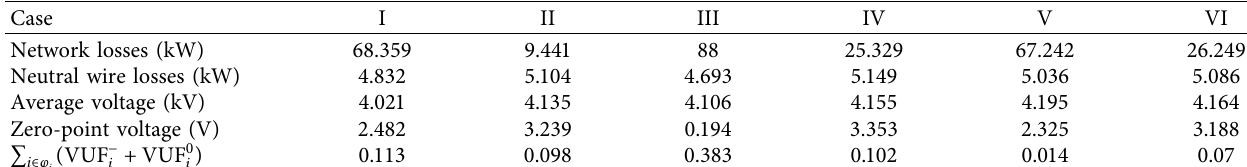
Table 2: Te values of diferent parts of the objective function.